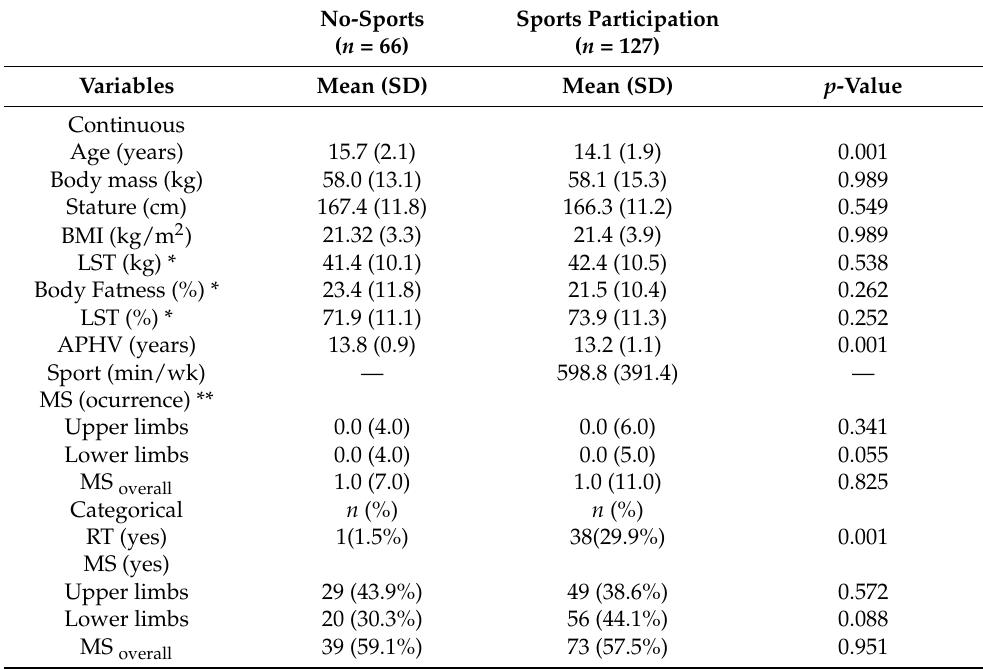
Table 1. General characteristics of the sample according to engagement in sports (ABCD—Growth Study; n = 193).